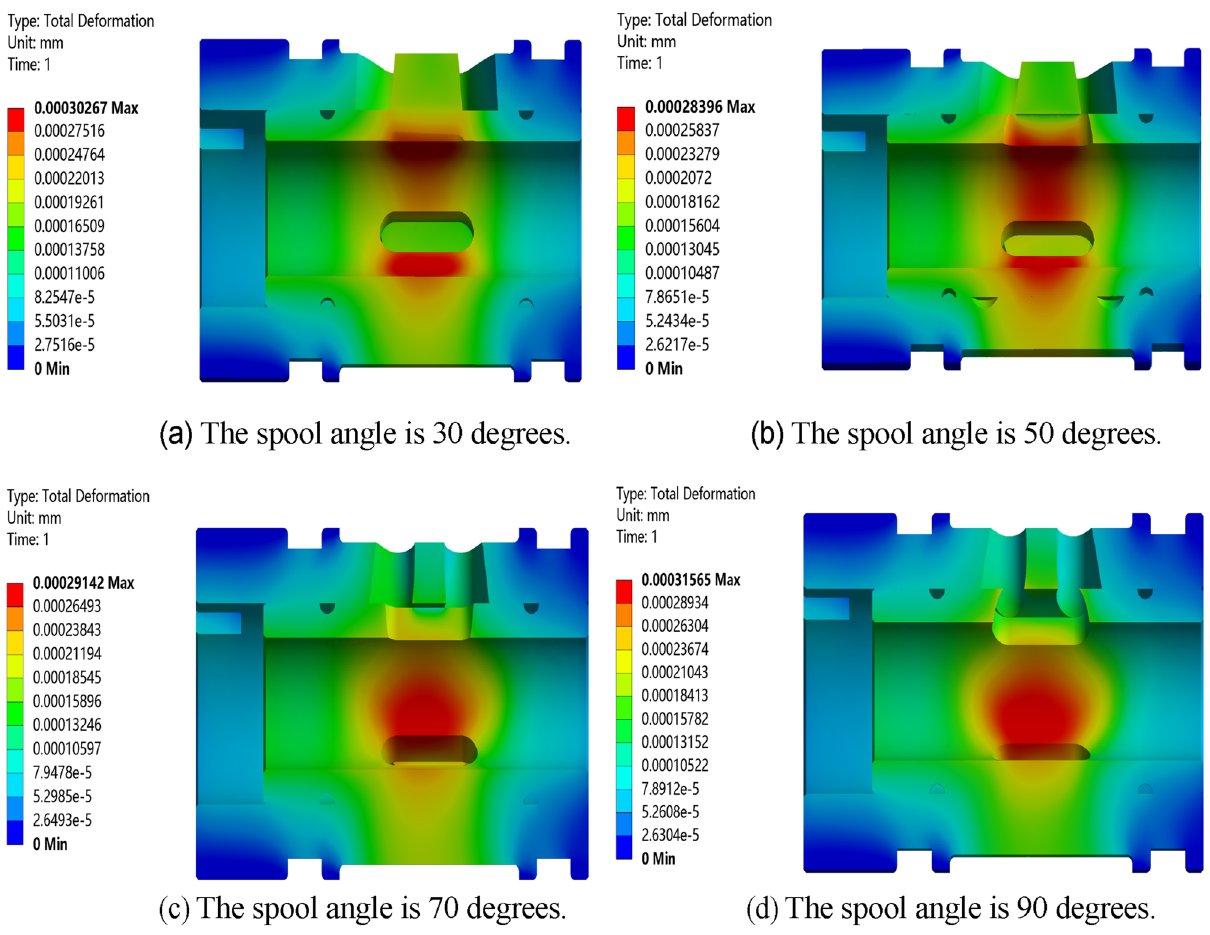
Figure 17. Deformation diagrams of valve sleeve and valve core before implementing buffer